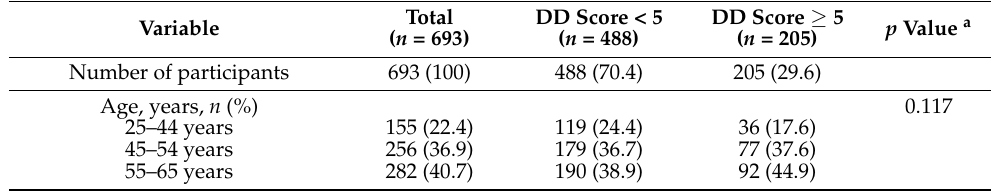
Table 1. Socio-demographic characteristics and behavioural risk factors of the study sample across dietary diversity